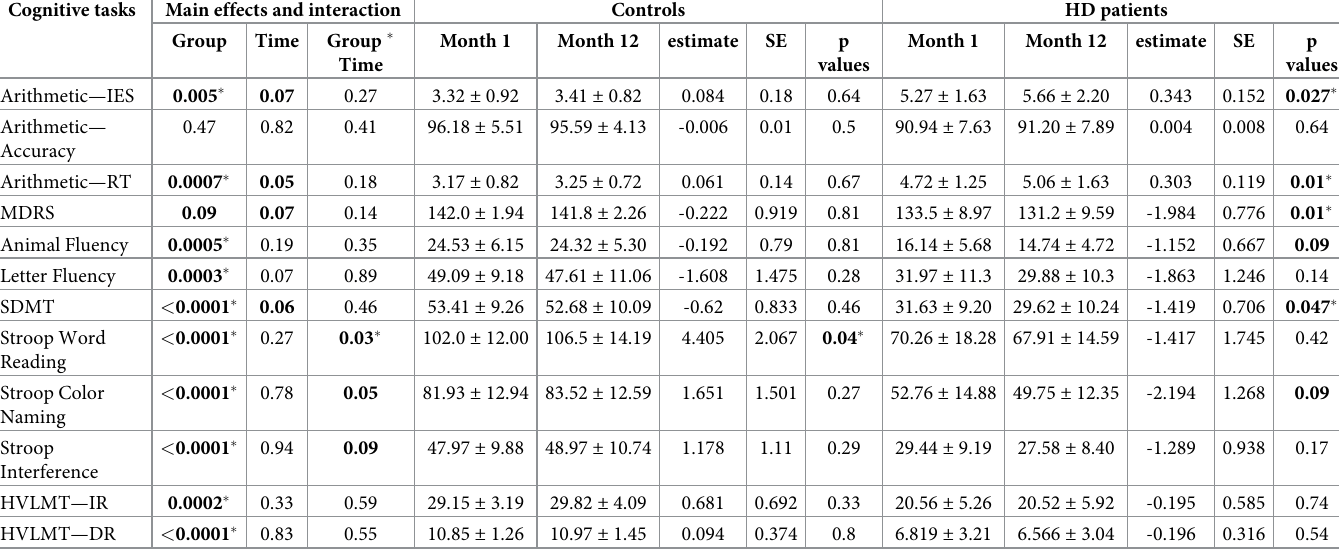
Table 3. Results of model comparisons testing the main effect of time, interaction of time and group (Controls and HD patients) and post-hoc comparisons testing the M1-M12 change in performance in Controls and in HD patients. Cognitive tasks Main effects and